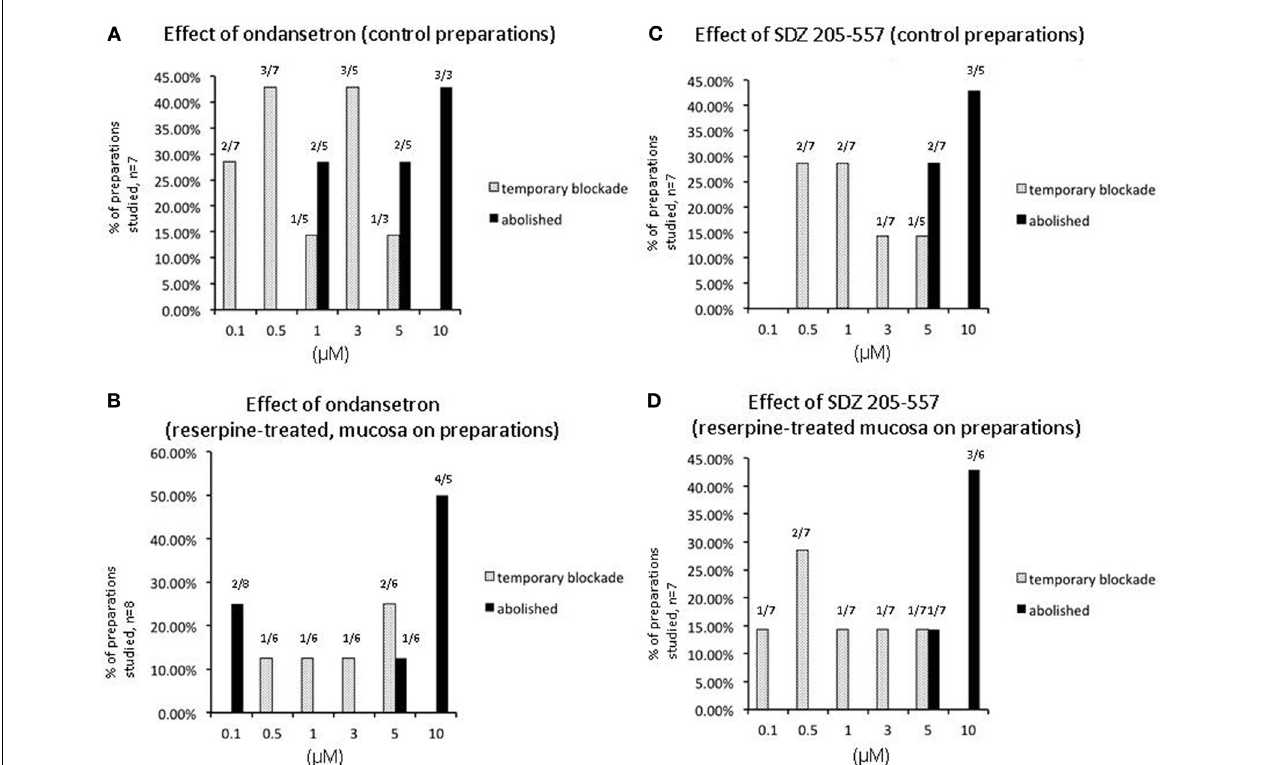
FIGURE 3 | Graph shows the number of preparations of colon from separate animals that showed a temporary or permanent blockade of peristaltic contractions in control preparations and preparations obtained from animals treated with reserpine prior to being euthanized. (A) Shows control animals, a large proportion of preparations showed a temporary blockade of peristaltic contracions upon application of